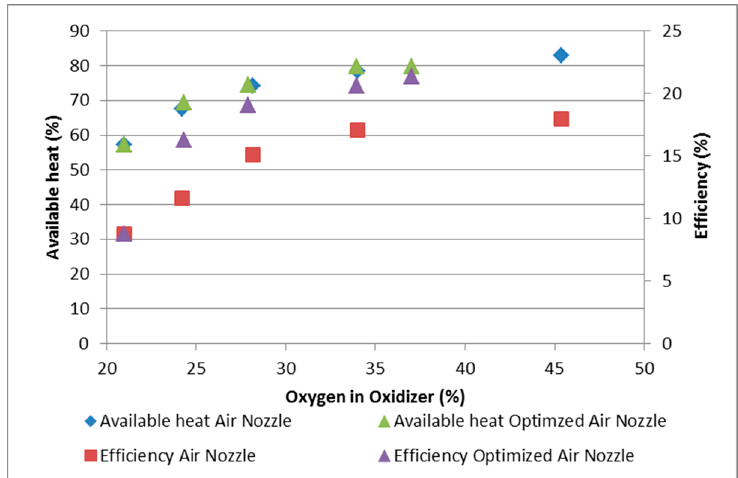
Figure 7. Comparison of the available heat and energy efficiency depending on the oxidizer oxygen concentration and burner type (calculated on the basis of the measurement results).